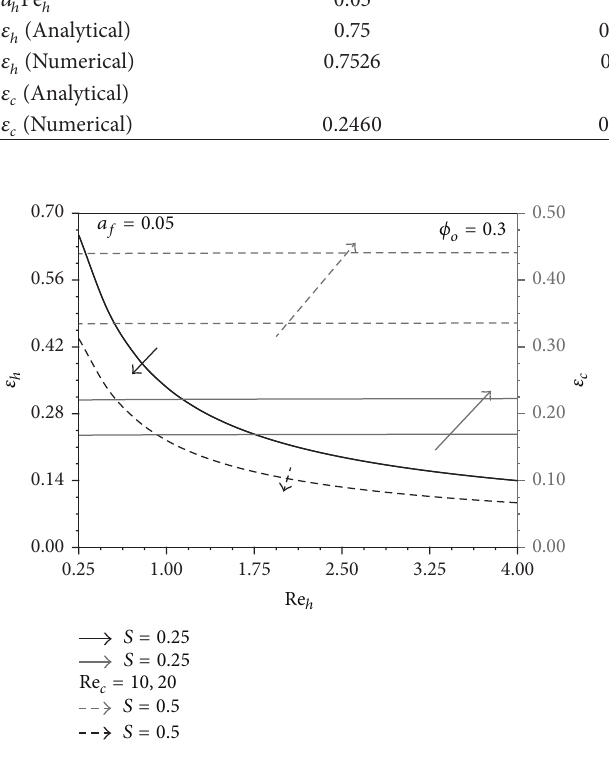
Figure 4: Effects of Re ℎ and Re 𝑐 on 𝜀 ℎ and 𝜀 𝑐 .